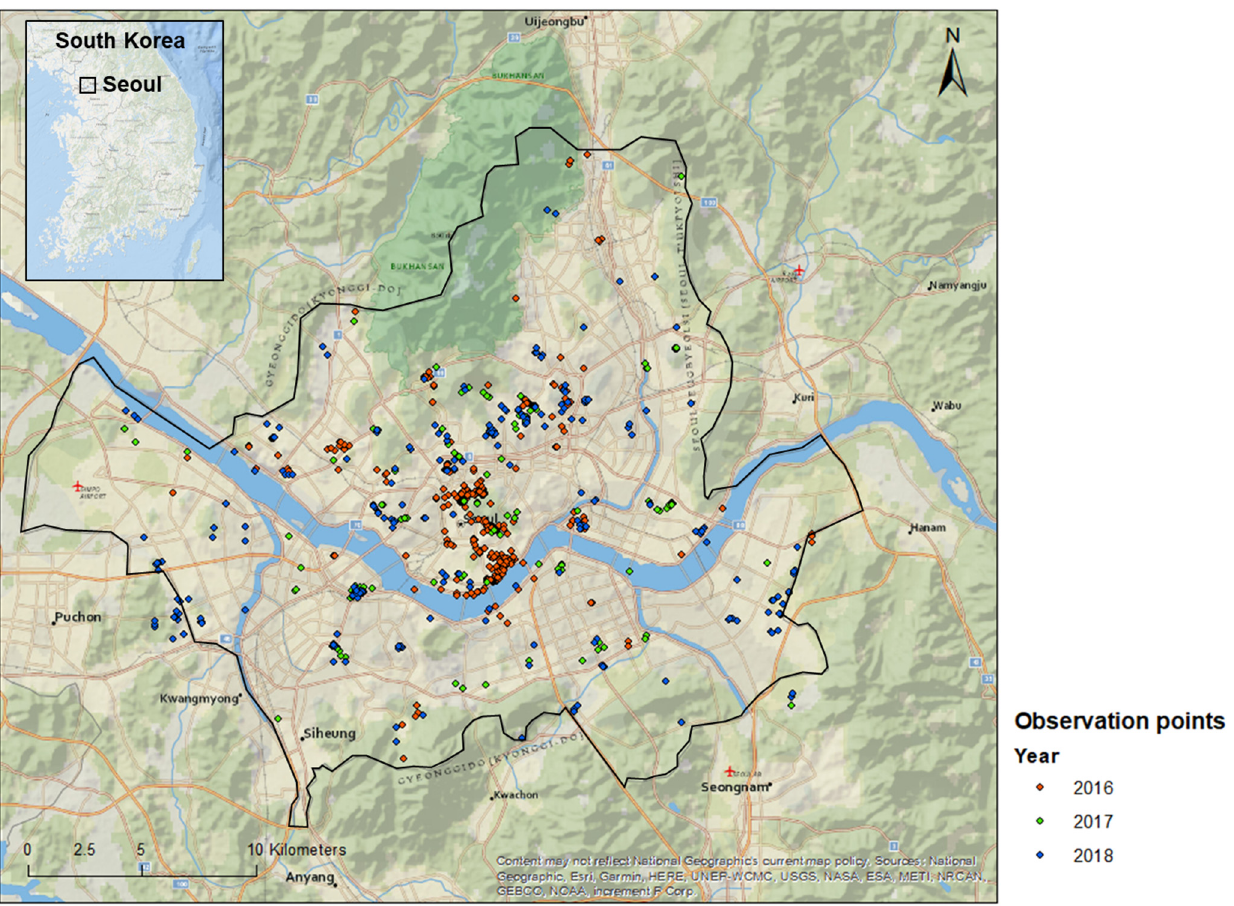
Figure 2. Locations of the observation points were mapped by the participants between 2016 and